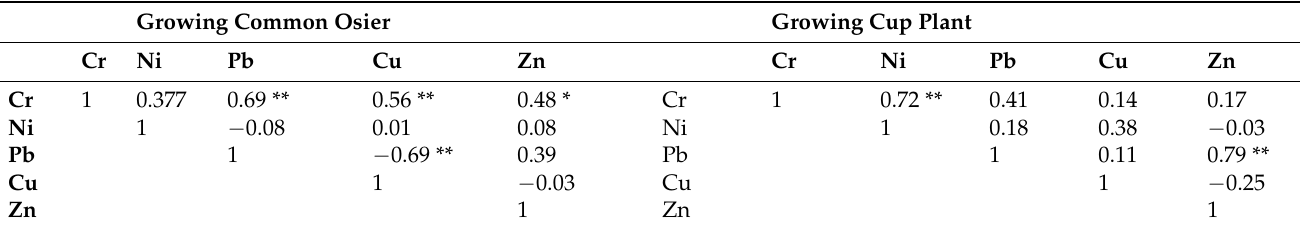
Table 4. Dependency between heavy metals in soil contaminated with sewage sludge. Growing Cup